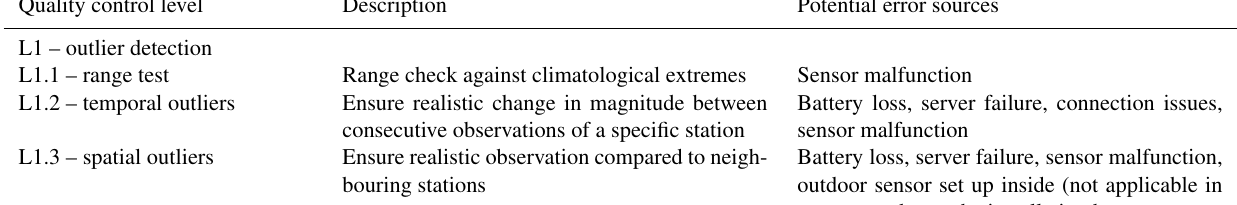
Table 5. Quality control levels, criteria for data filtering and potential error sources for crowdsourced air temperature measurements.